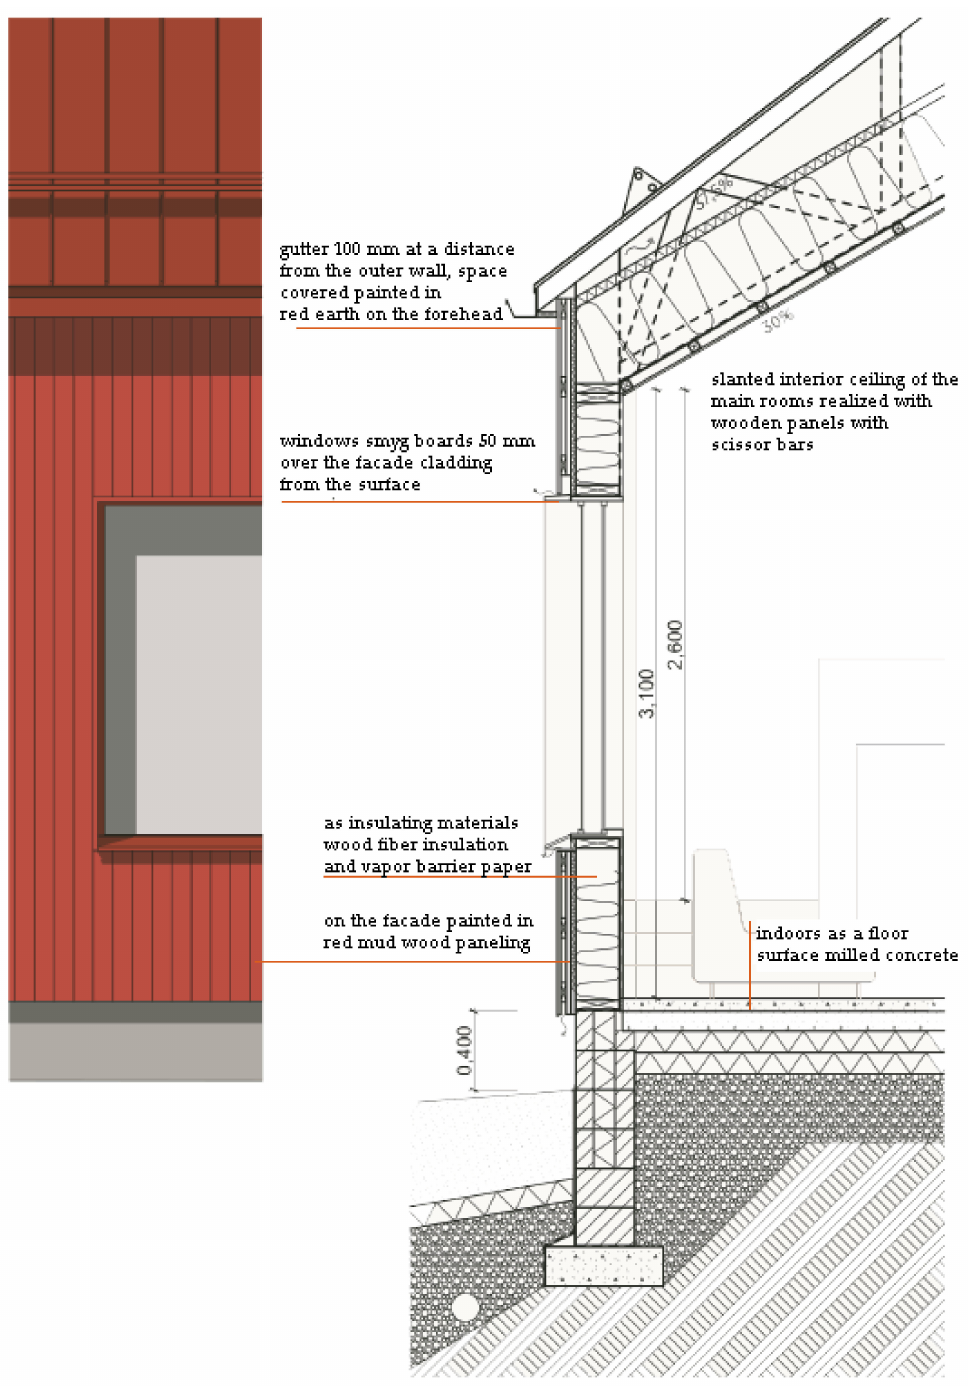
Figure 15. A typical system